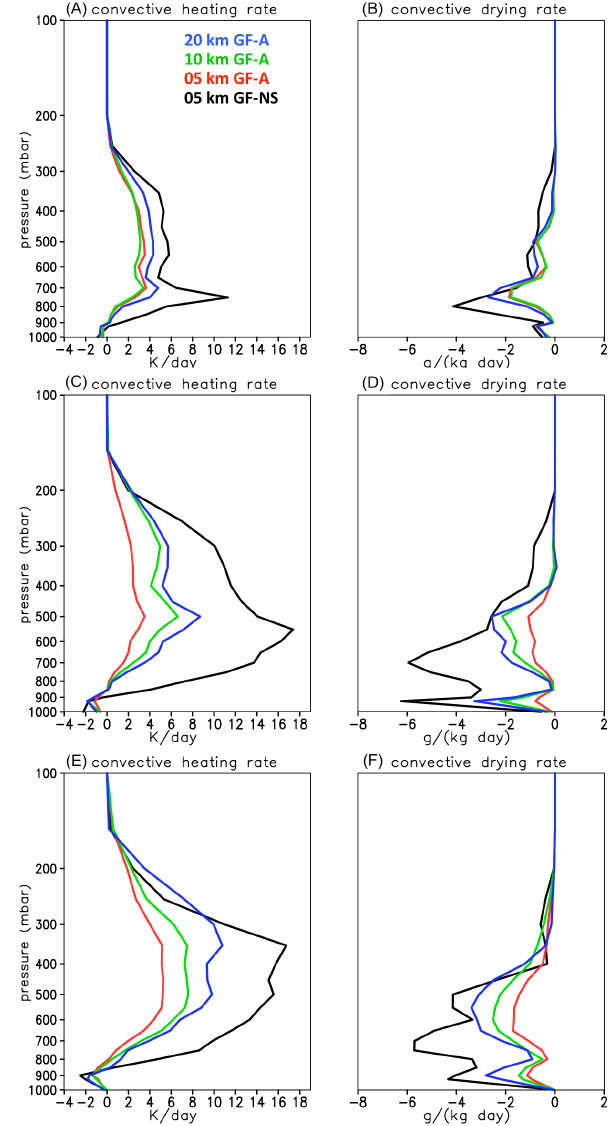
Figure 8. Satellite depiction over the domain of integration on 8 January 2013, 18:00UTC, showing the location of three boxes A, B, and C that were used for averaging. Figure 9: Vertical profiles of convective heating (A, C, and E) and drying (B, D, and F) for box A (A,B), box B